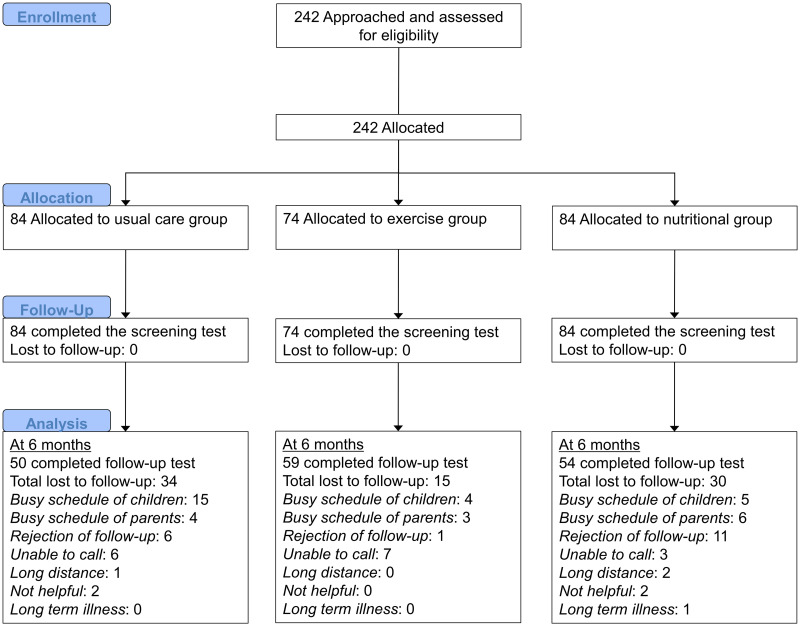
CONSORT flowchart.